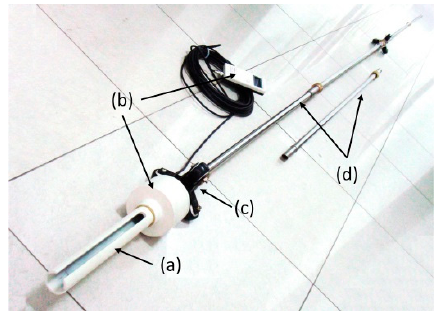
Figure 3. Sensor installation equipment (( a ). Slot; ( b ). goniometer; ( c ). roller; ( d ). pushrod).